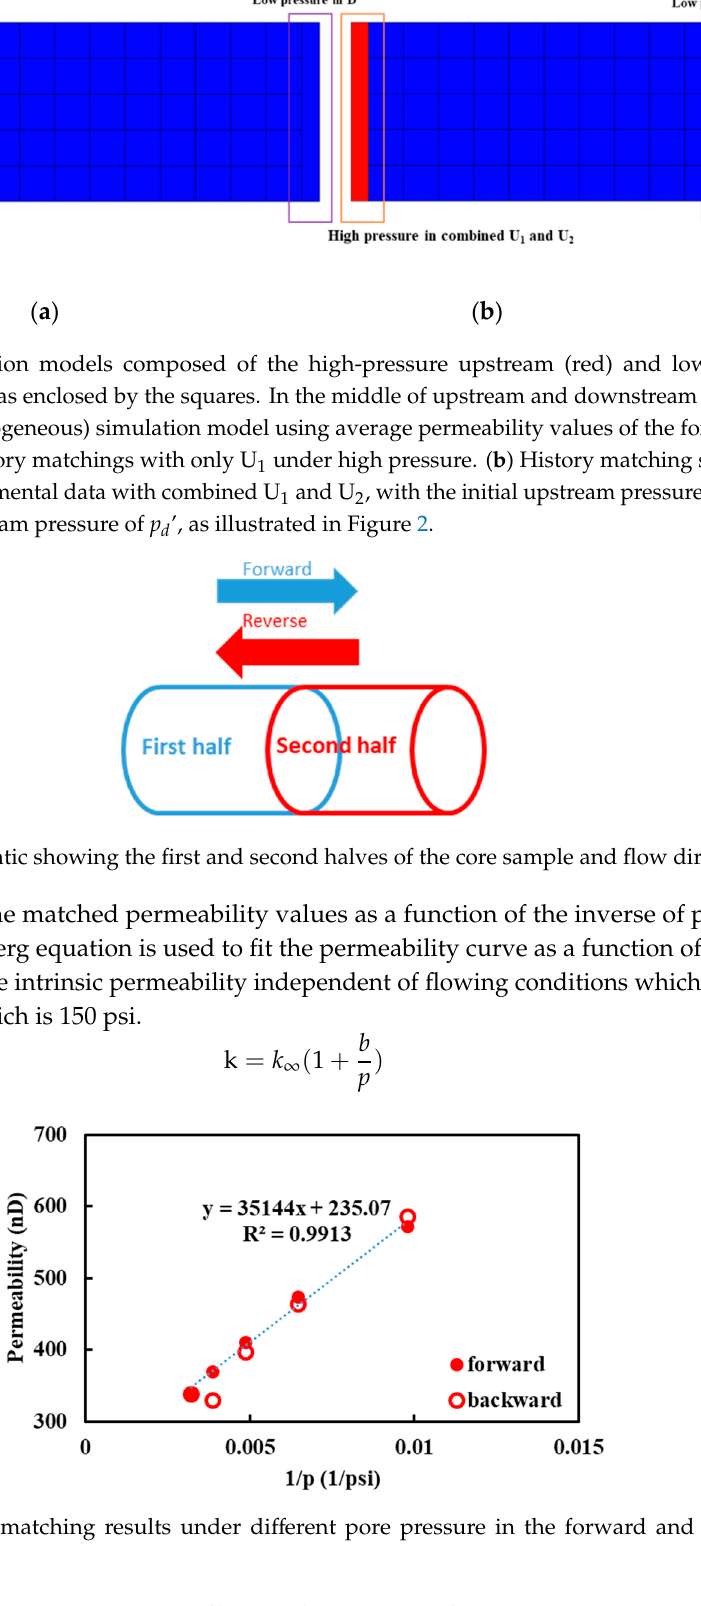
8 of 13 Figure 5. Experimental and simulated pressure curves in the pulse-decay experiment. Experiment results include pressure curves by flowing nitrogen in the forward and backward directions, pressure ranges from 100 psi to 300 psi (from ( a ) to ( e )). The pressure curve is adjusted within ± 0.2 psi using the same initial downstream pressure p d for better visualization of comparing pressure responses in different directions. Simulated pressure curves are generated by matching the late-time pressure